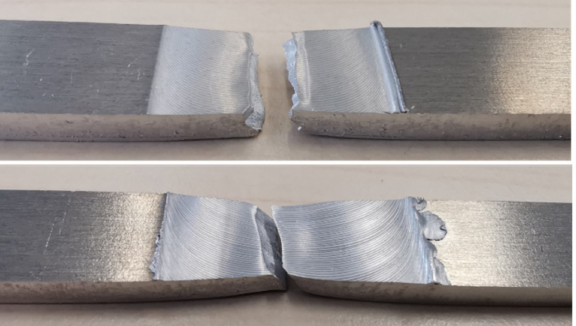
Figure 13. Comparison of the fracture patterns between a weld with tool 1-15-0 ( top ) and tool 2-20-8 ( bottom ); joint gap width 0.3 mm